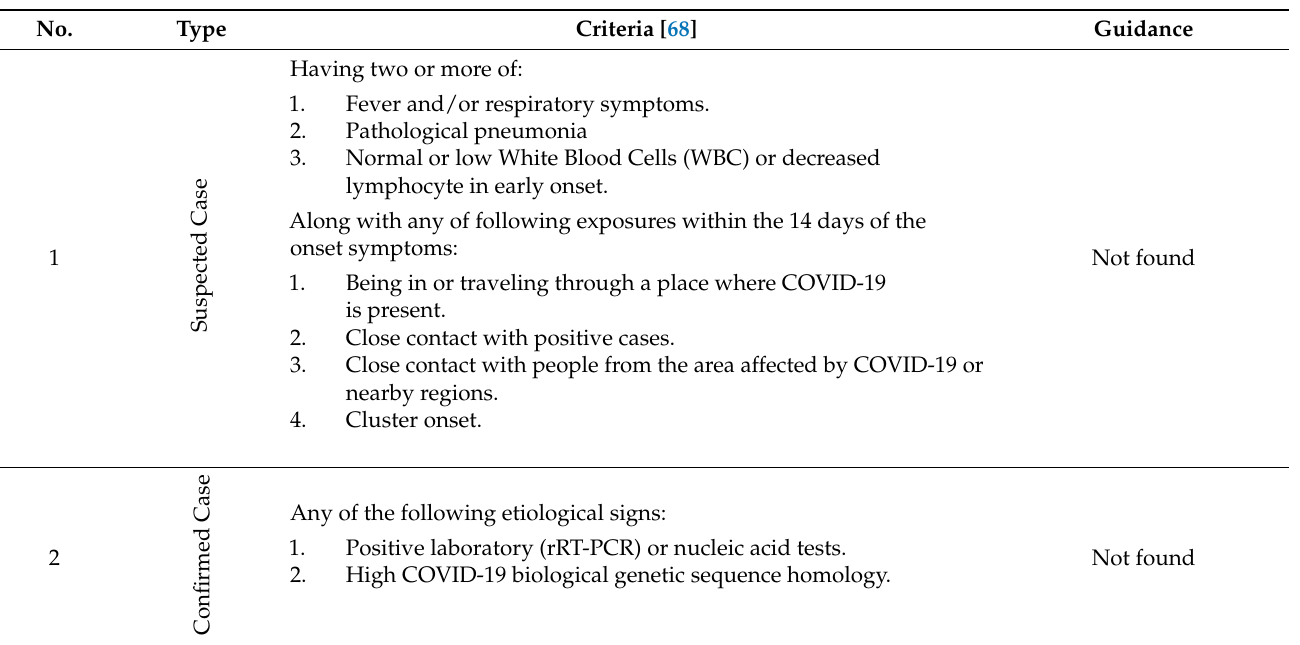
Table 5. Classification criteria of COVID-19 patients in approach 2.